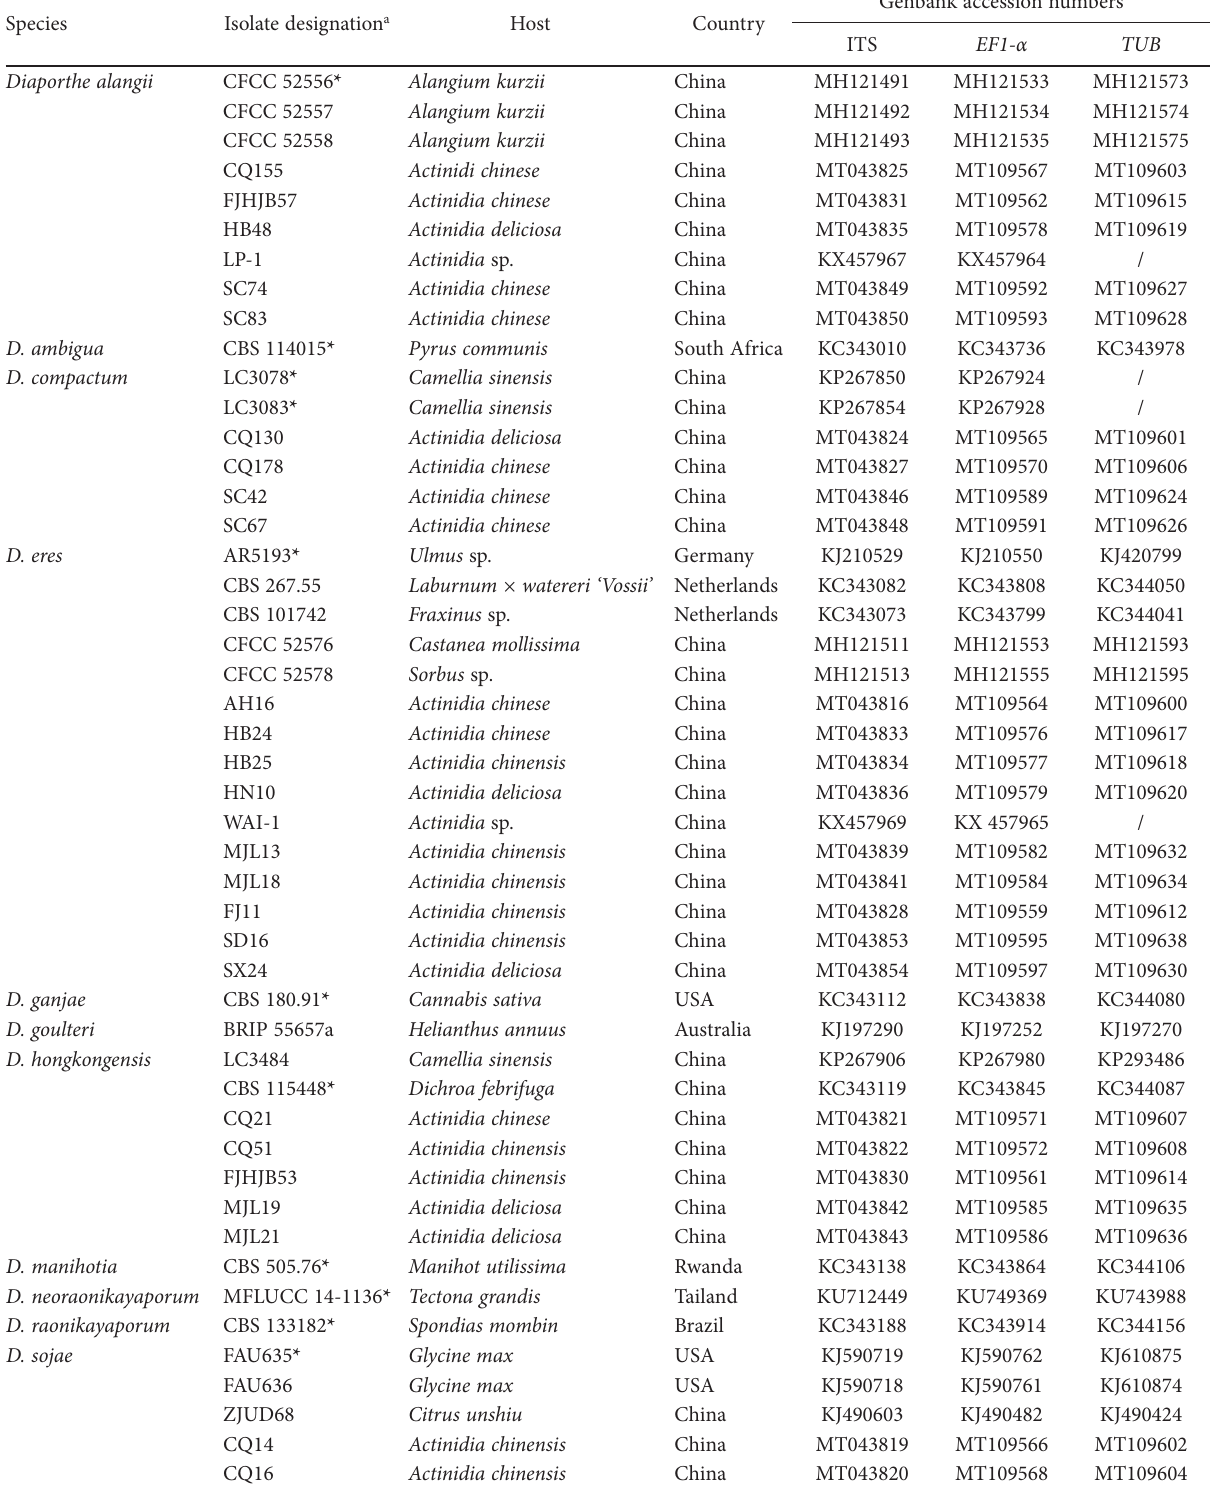
Table 1. Sources and GenBank accession numbers of isolates included in this